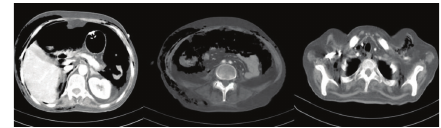
Figure 1: Thoracoabdominal CT, showing detached gastric wall from catheter insertion site and massive subcutaneous emphysema through cervical, thoracic, and abdominal region.